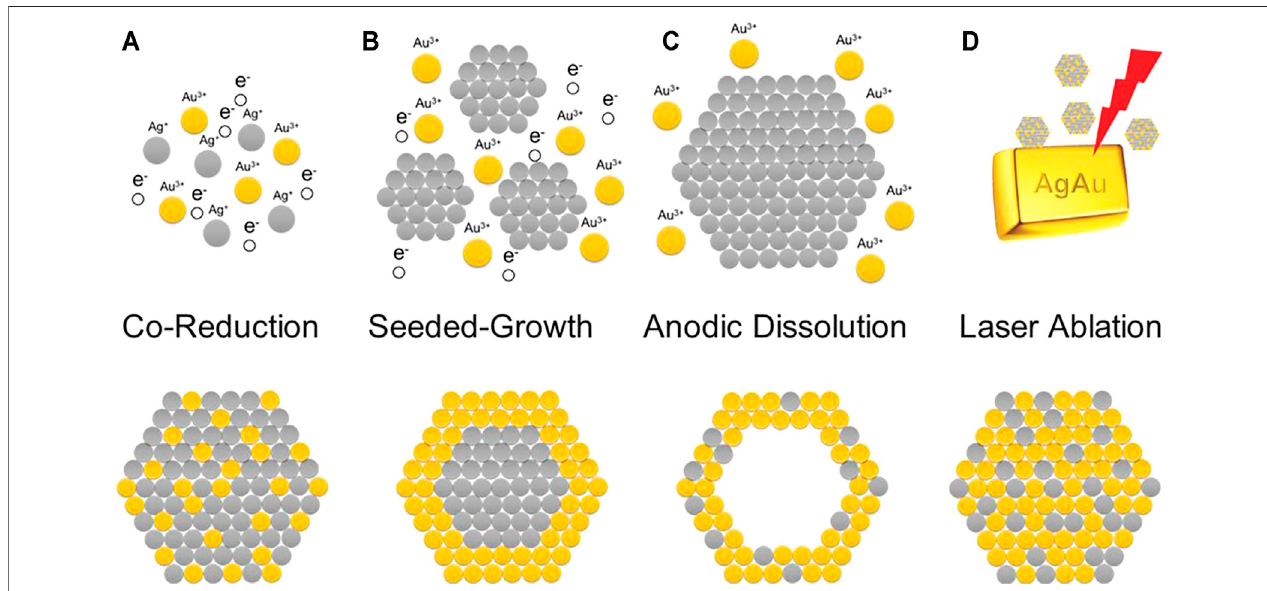
FIGURE 1 | Synthesis methods for bimetallic nanoparticles for various structures. Reprinted from (Loza et al., 2020) with permission from Wiley Online Library.